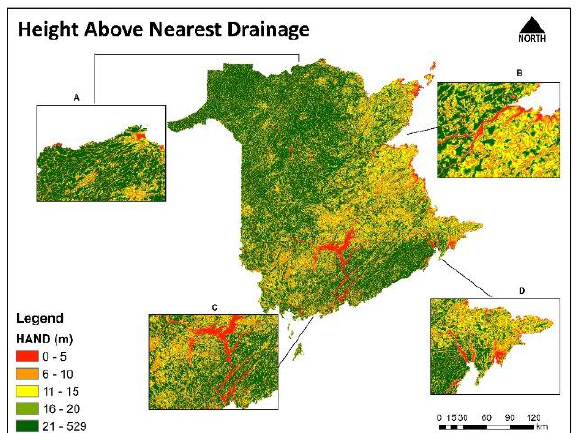
Geosciences 2020 , 10 , x FOR PEER REVIEW Figure A4. Height Above Nearest Drainage. Figure A4. Height Above Nearest Drainage. Figure A4. Height Above Nearest Drainage.